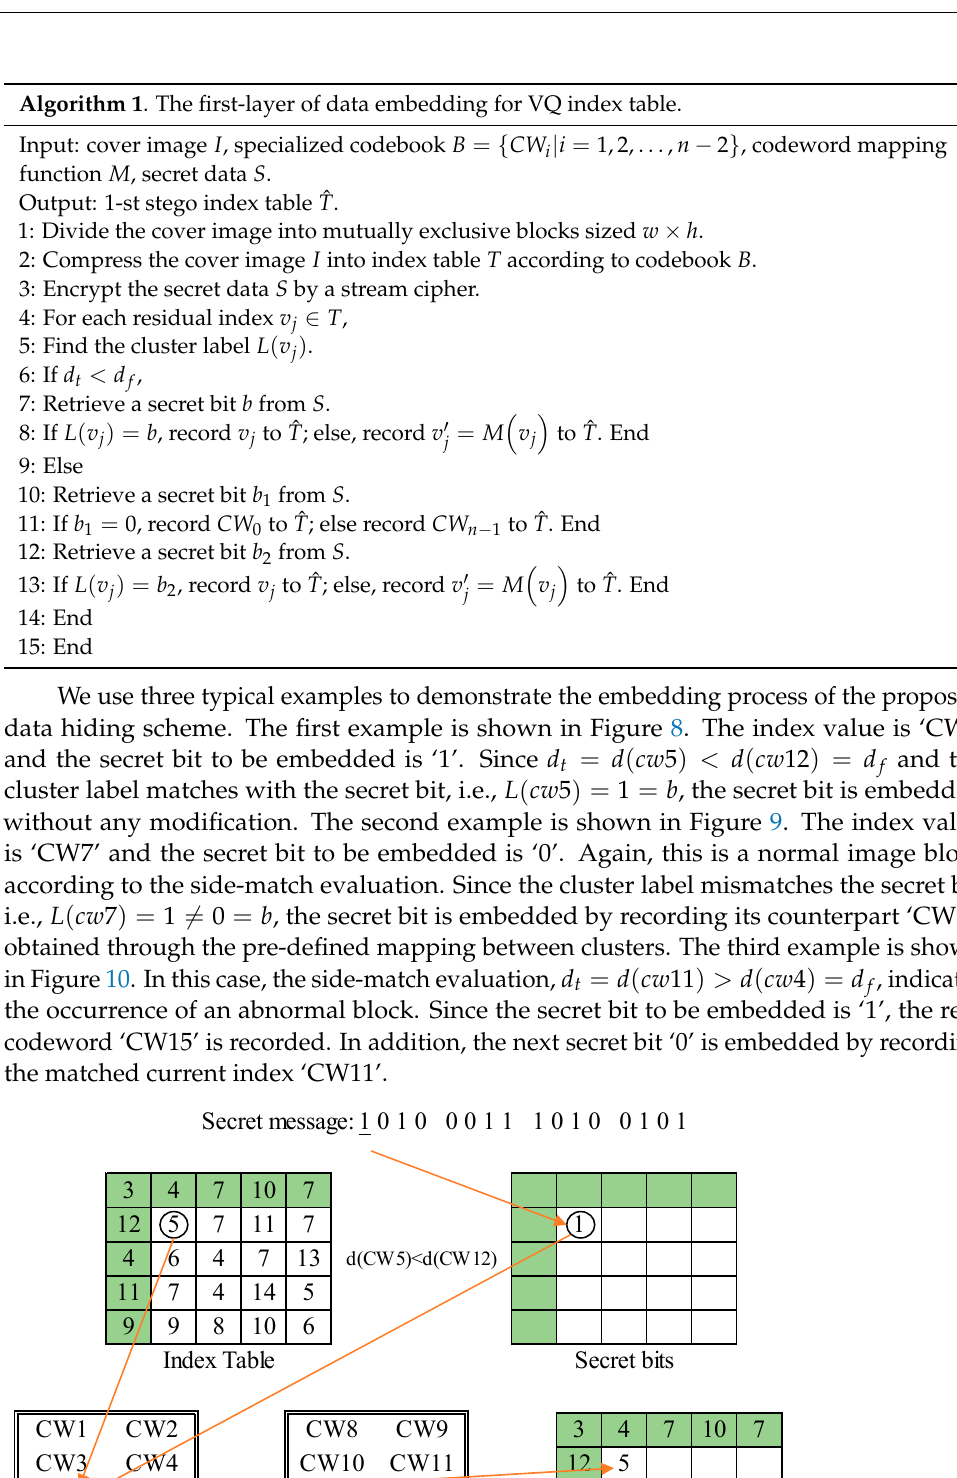
Algorithm 1 The first-layer of data embedding for VQ index table.